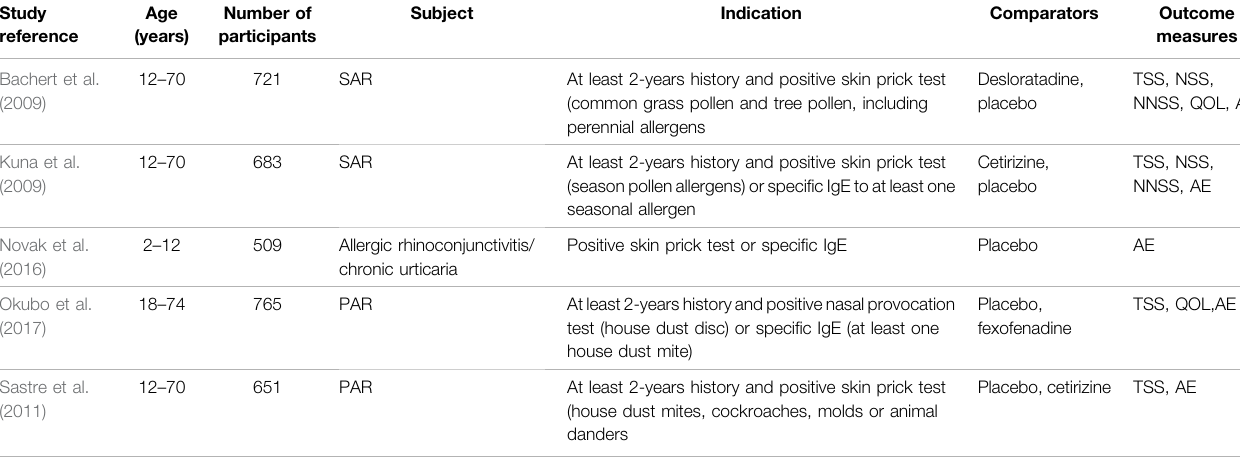
TABLE 1 | The characteristics of included